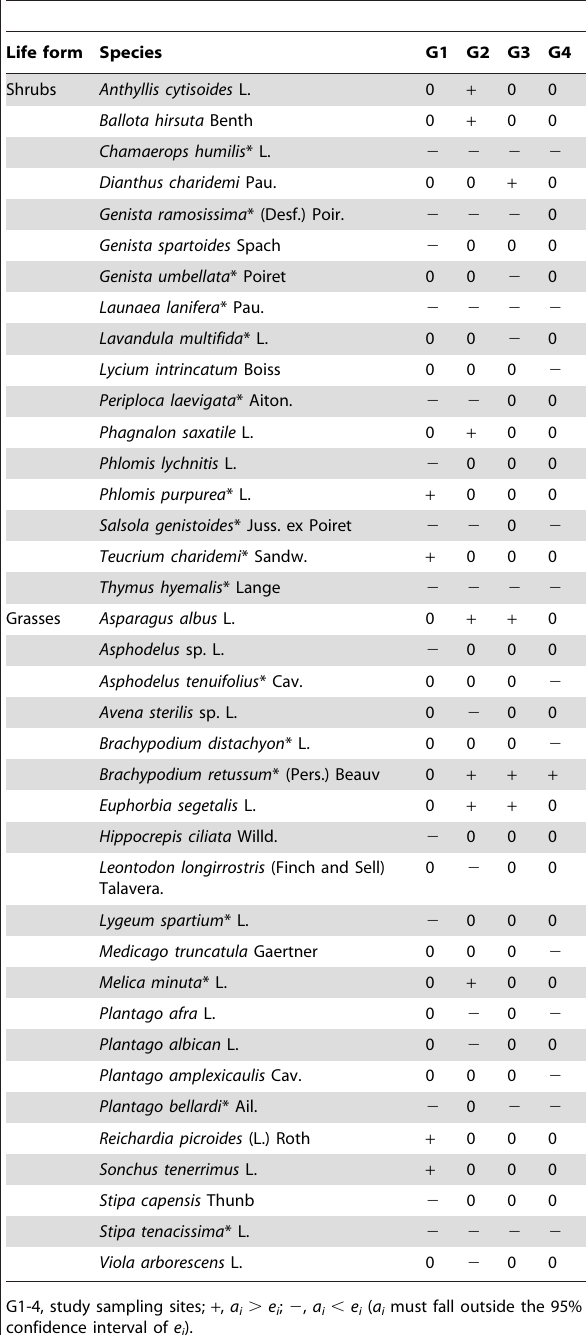
Table 3. Plant species association type along a grazing gradient in Cabo de